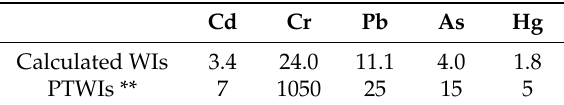
Table 3. Comparison of weekly intakes (WIs) with provisional tolerable weekly intakes (PTWIs) ( µ g/kg bw/week). Cd Cr Pb As Hg